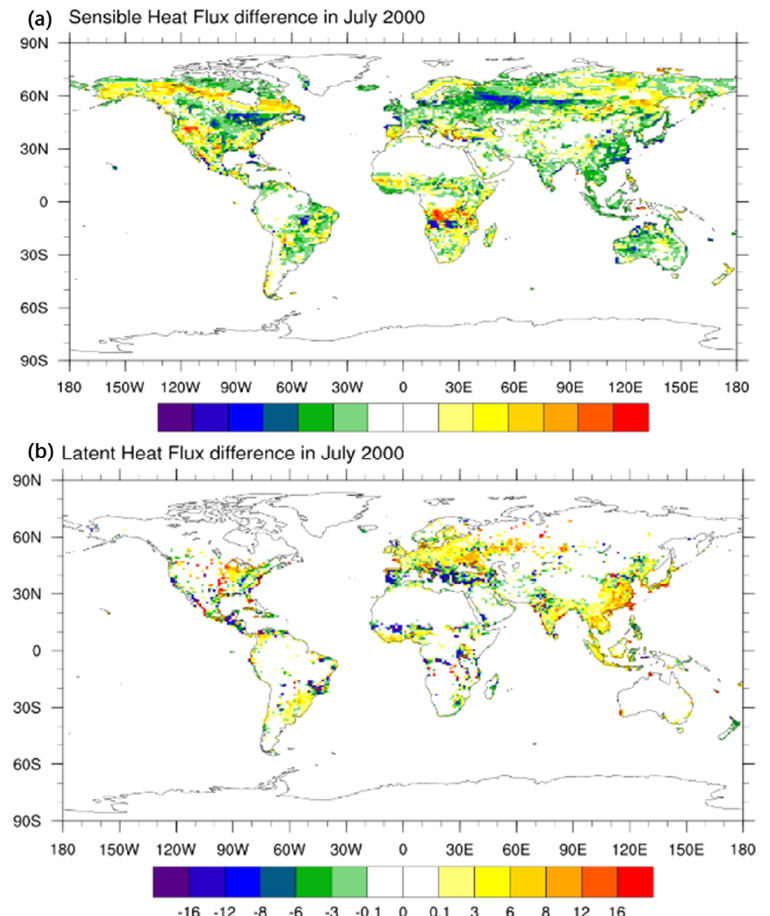
Figure 5. The difference of ESACCI and CLM_LS for ( a ) sensible heat fluxes (Hs) and ( b ) latent heat fluxes (Le) (W/m 2 ) (July 2000).